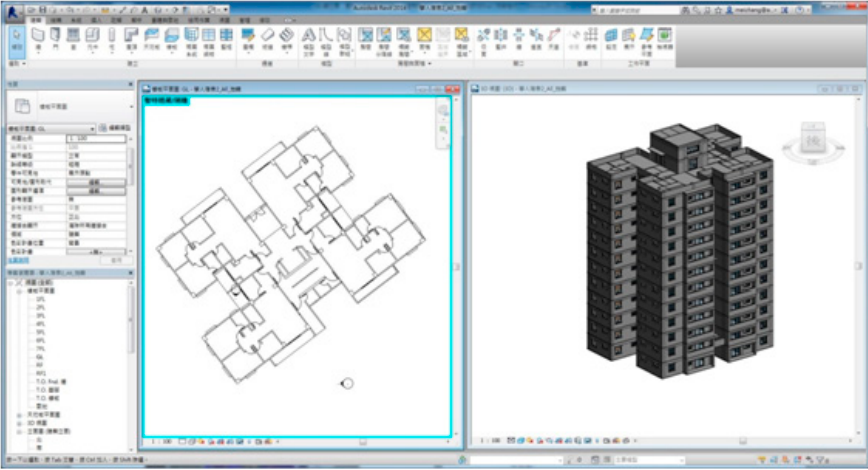
Figure 3. Building Information Modeling (BIM) model of simulation case.